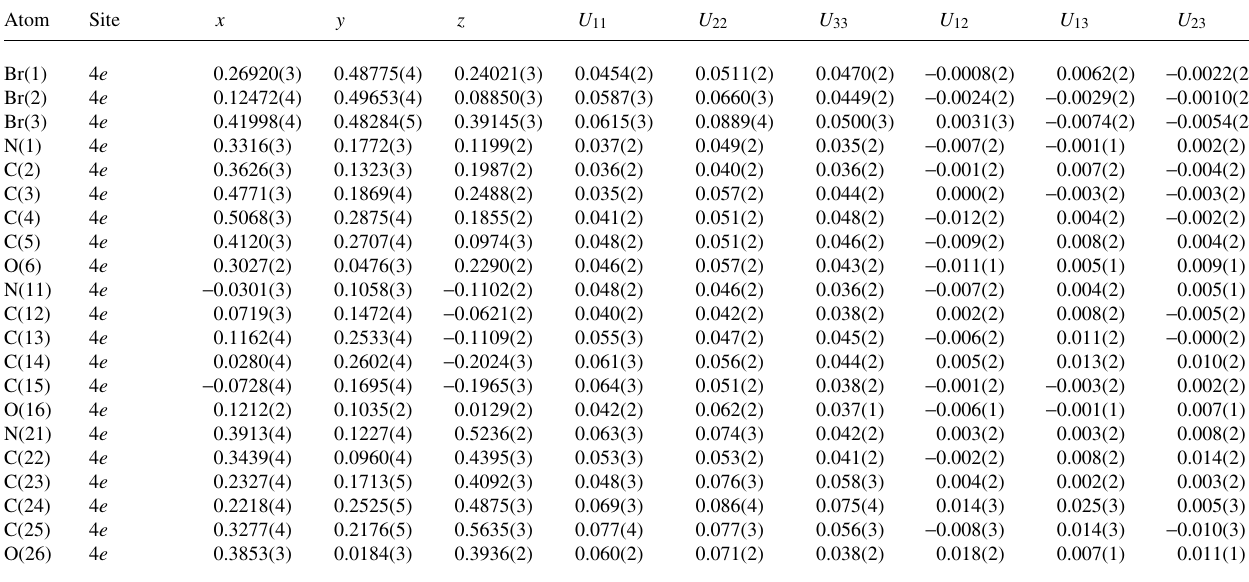
Table 3. Atomic coordinates and displacement parameters (in Å 2 ) .